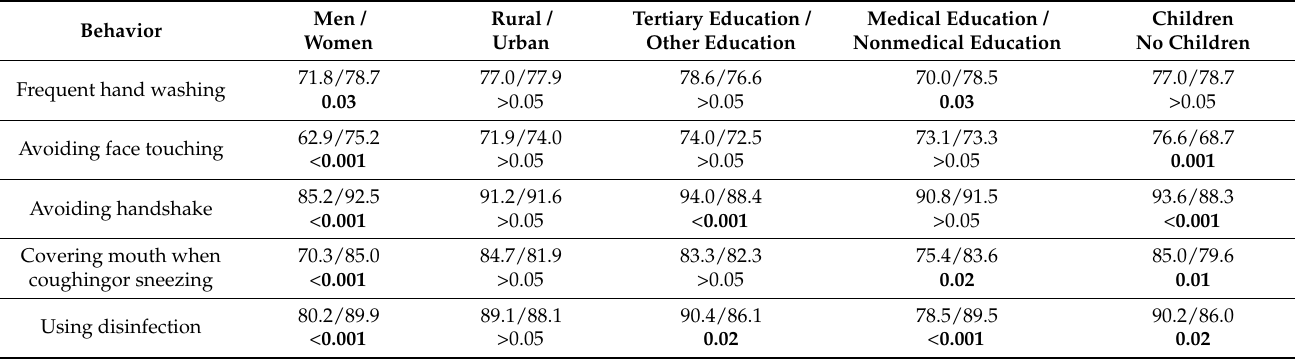
Table 2. The adherence (%) to preventive measures in different subgroups of the studied population ( n = 1337). p -value indicating significant differences is given in bold (Pearson’s χ 2